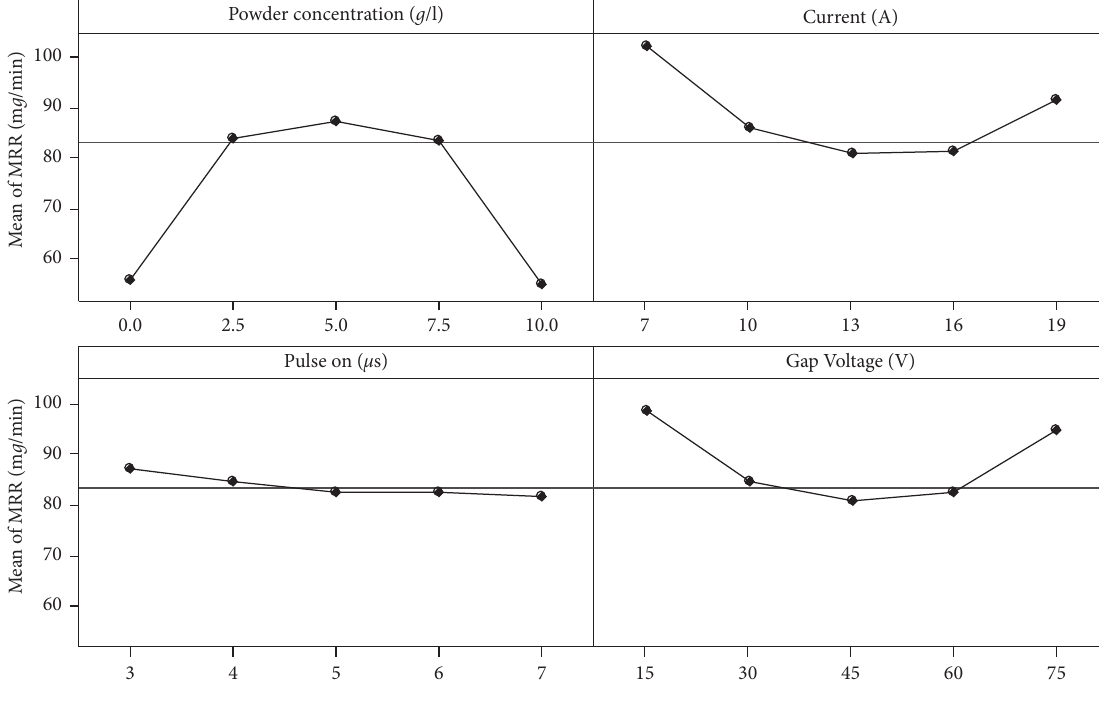
Figure 1: Impact of various p-p on MRR.